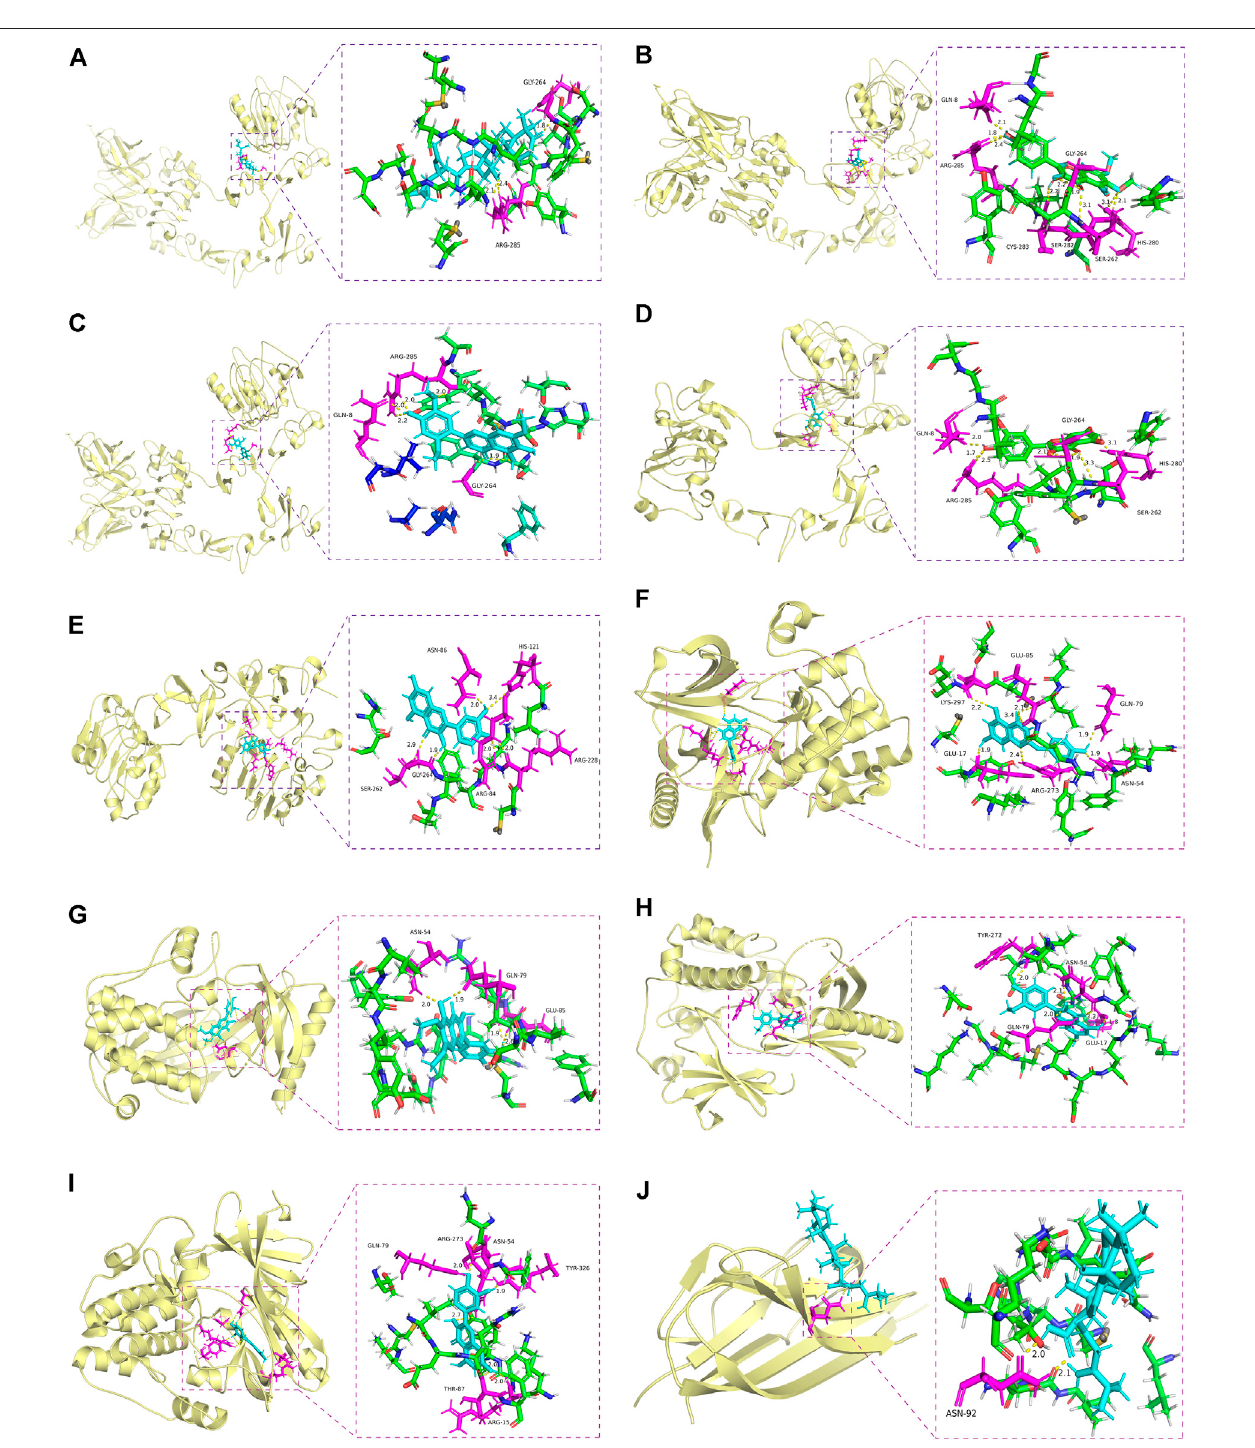
FIGURE 6 | Molecular docking of active compounds in core targets. (A) Alisol B 23-acetate-EGFR. (B) Eupalitin-EGFR. (C) Isoarcapillin-EGFR. (D) Isorhamnetin- EGFR. (E) Quercetin-EGFR. (F) Demethoxycapillarisin-AKT1. (G) Eupatolitin-AKT1. (H) Isorhamnetin and AKT1. (I) Quercetin-AKT1. (J) Polyporenic acid C -TNF.